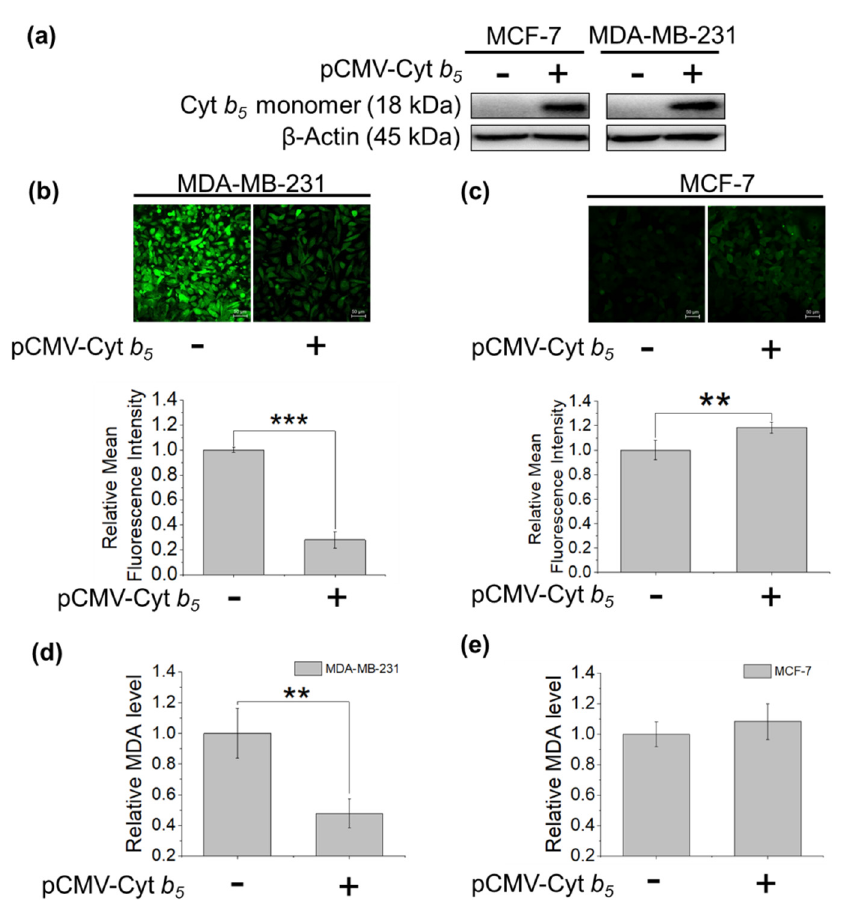
Figure 2. Overexpression of Cyt b 5 and its regulating effect on the oxidative stress in MDA-MB-231 and MCF-7 cells. ( a ) Validation of the overexpression of Cyt b 5 in MDA-MB-231 and MCF-7 cells by western blot. ( b , c ) Detected ROS levels of MDA-MB-231 ( b ) and MCF-7 ( c ) cells by treatment with DCFH-DA reagent. (**) p < 0.01; (***) p < 0.001. ( d , e ) Analysis of MDA levels in MDA-MD-231 ( d ) and MCF-7 cells by using lipid peroxidation MDA assay kit. (**) p < 0.01; (***) p < 0.001.